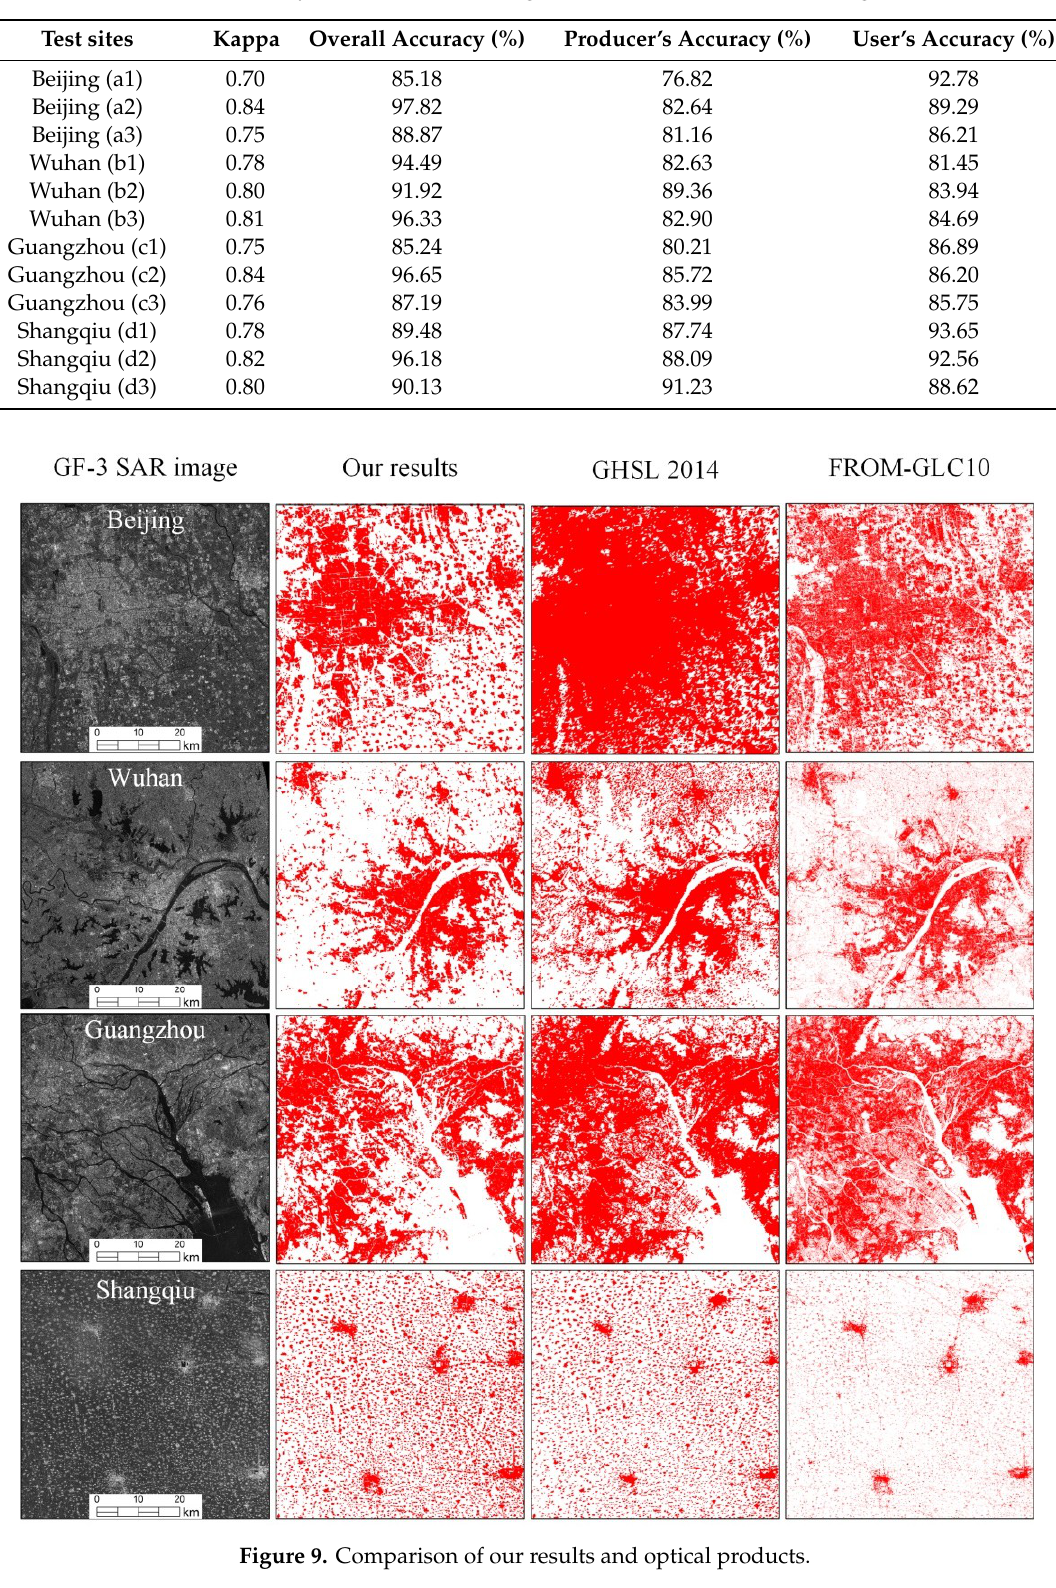
Table 4. Accuracy evaluation of building-area extraction results in four regions.